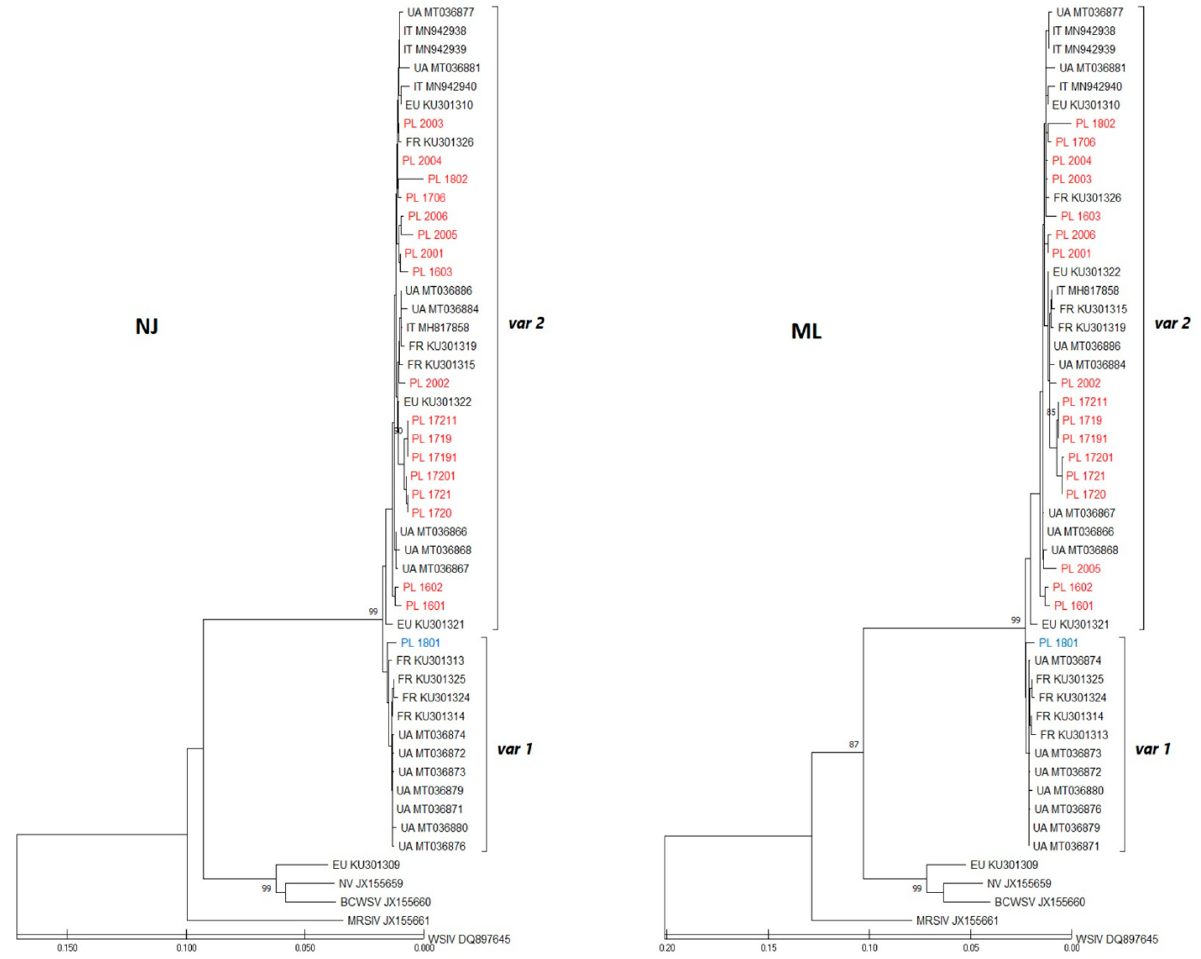
Figure 3. Analysis of the partial mimivirus major capsid protein (MCP) sequences using the neighbor-joining (NJ) and maximum-likelihood methods (ML). For each sequence, the country of origin is indicated (two-letter country code: PL— Poland; UA—Ukraine; IT—Italy; FR—France; EU—other European countries). Polish isolates are marked in blue ( var1 ) and red ( var2 ). Bars indicate the scale of genetic distance between sequences.